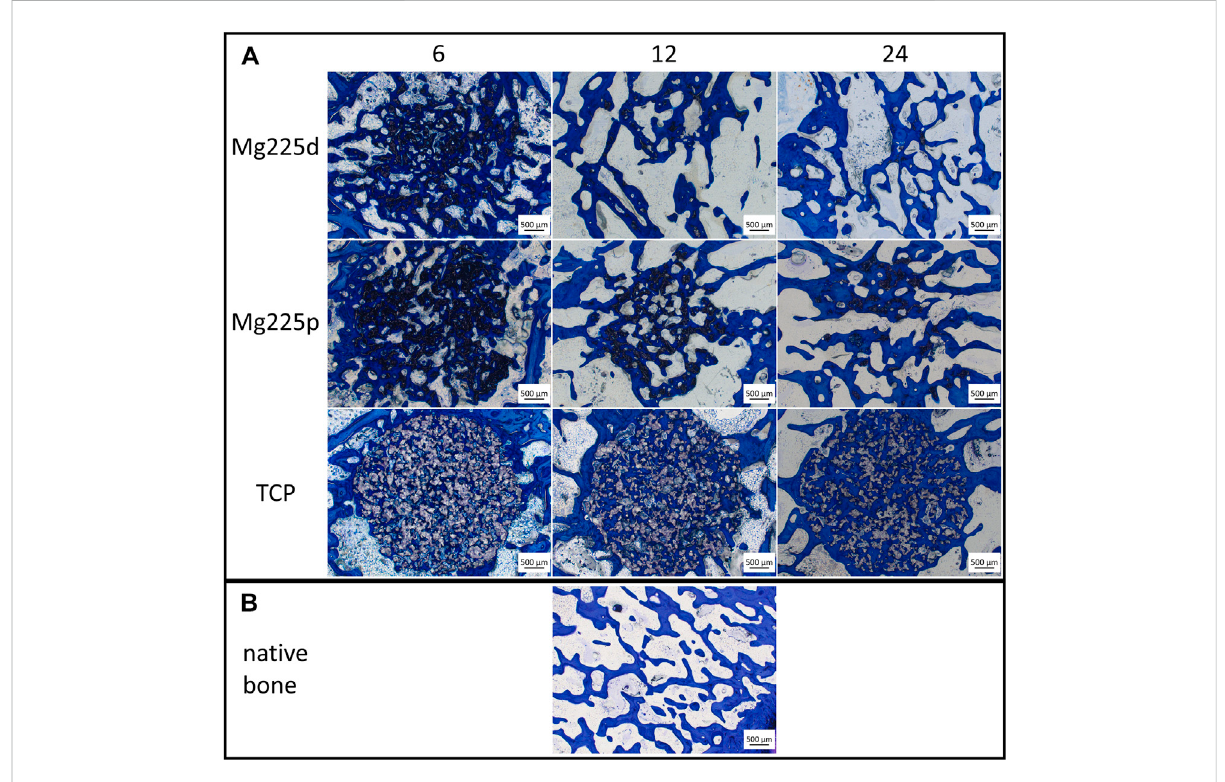
FIGURE 8 Histological thick sections (toluidine blue staining, magni fi cation ×2.5/0.085) (A) from the center of the Mg225d, Mg225p and TCP scaffolds in cross section after 6, 12 and 24 weeks and (B) comparison to native cancellous bone of the lateral femoral condyle.